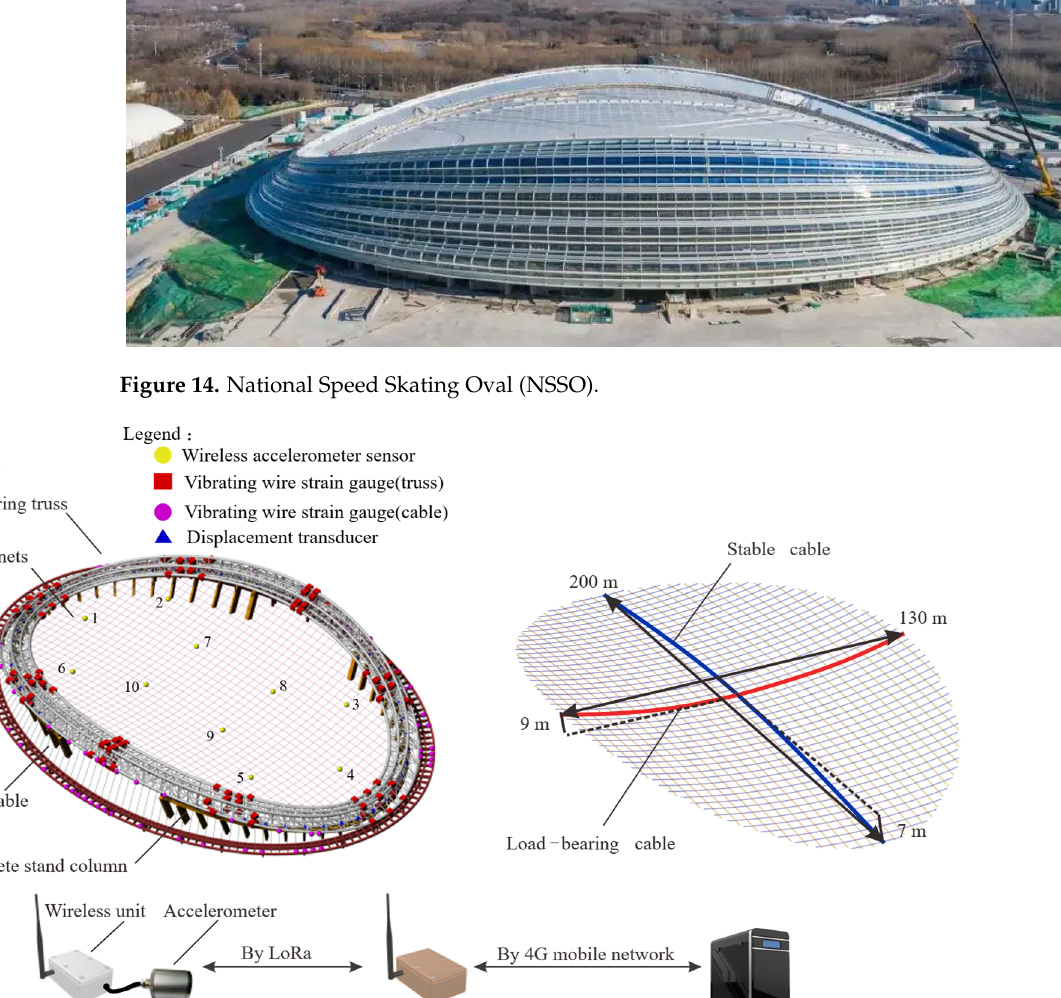
Figure 14. National Speed Skating Oval (NSSO).